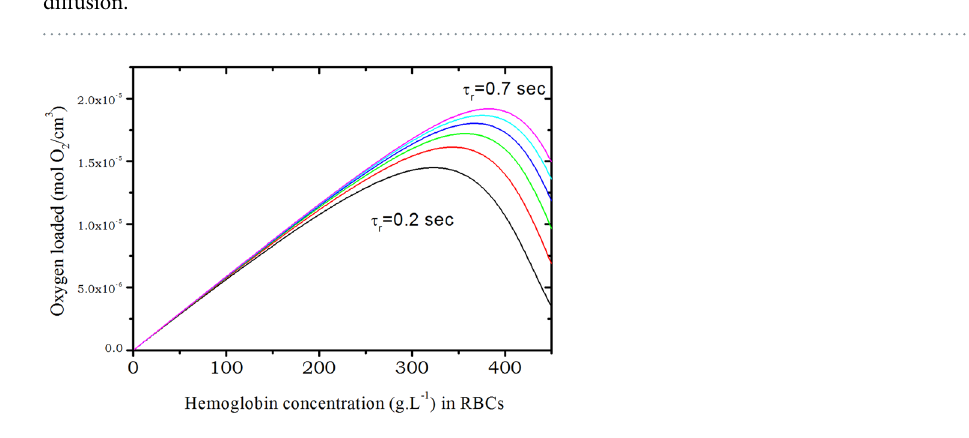
Figure 7. Same as Fig. 6 but this time computed with including the concentration dependence of Hb diffusion